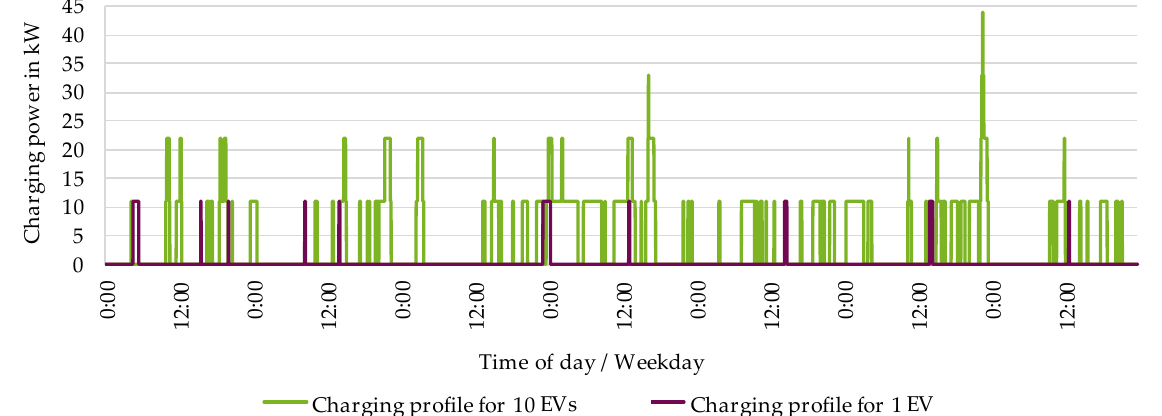
Figure 6. Exemplary weekly charging profile for an electric vehicle and the accumulated charging profile for ten electric vehicles [28].